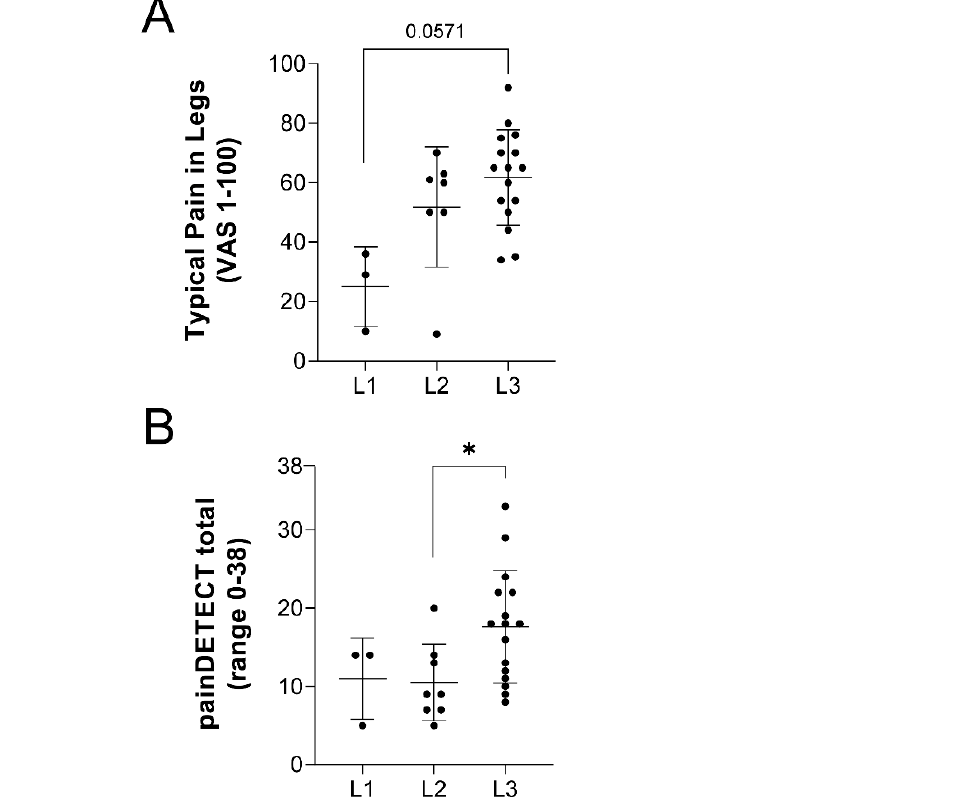
Figure 1. VAS scores and painDETECT responses identify pain across lipedema stages. ( A ) Re- sponses on the visual analogue scale (VAS) in patients with lipedema regarding their typical leg pain. p = 0.0105 across stages by ANOVA. ( B ) Calculated painDETECT questionnaire scores across lipedema stage. p = 0.0271 across stages by ANOVA. Stage 1 n = 5, Stage 2 n = 13, Stage 3 n = 16. Mean ± SD. * indicates p < 0.05 by post hoc multiple comparison test. Table 1. Physical characteristics of participants assessed for pain and von Frey